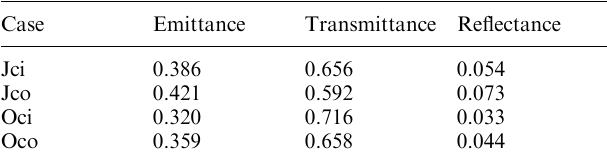
Table 5. Derived ice cloud radiative properties in the terrestrial spectral